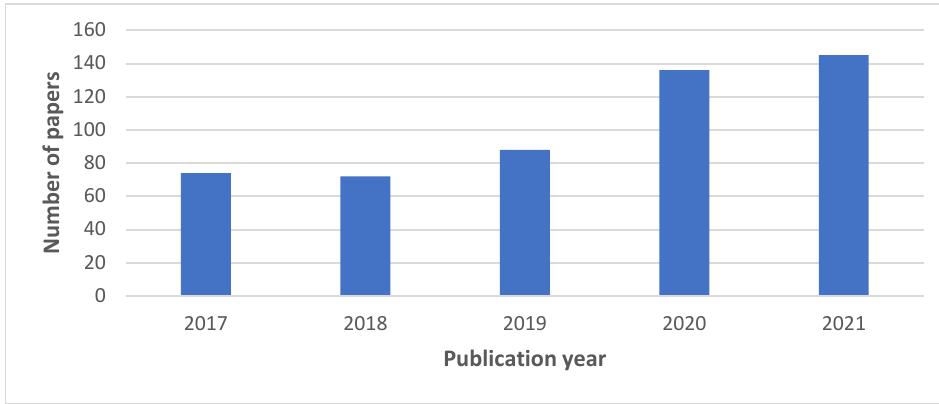
Figure 1. Distribution of the extracted papers by publication year.